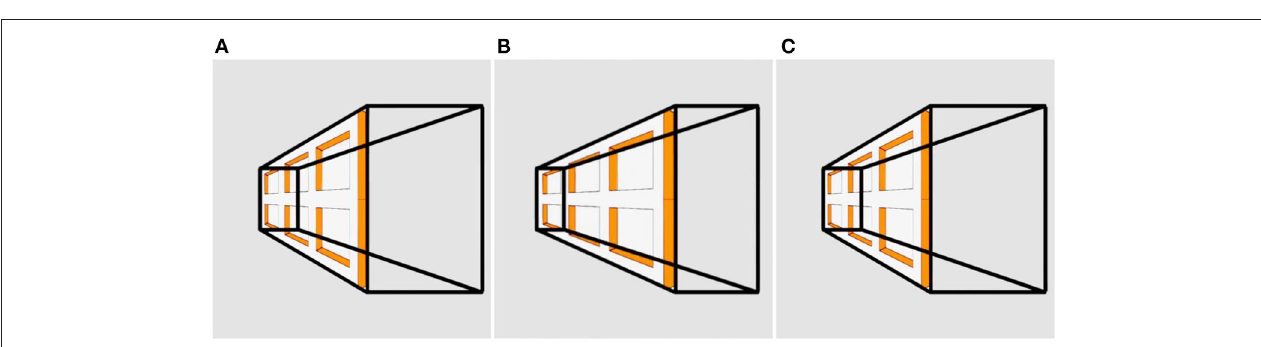
FIGURE 5 | Stereo disambiguation of a trapezoidal prism. When viewed in stereo, this rotating trapezoidal prism reverses its direction from time to time, like the spinning ballerina. Sometimes the large square face looks nearer as it rotates in one direction. Sometimes the smaller face looks nearer and it seems to rotate in the opposite direction. Panels (A) and (C) are identical, while panel (B) contains disparity. Please see Supplementary Video 5 for an animation.